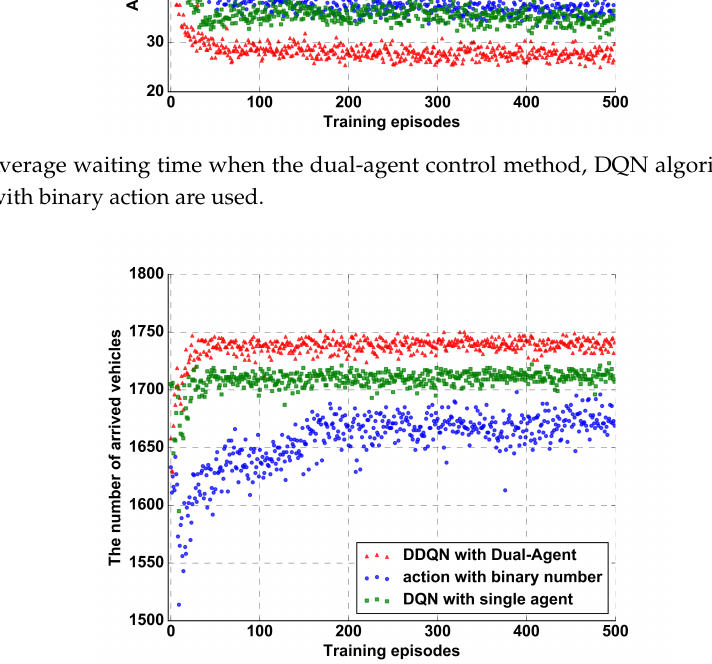
Figure 8. The number of arrived vehicles when the dual-agent control method, DQN algorithm, and control algorithm with binary action are